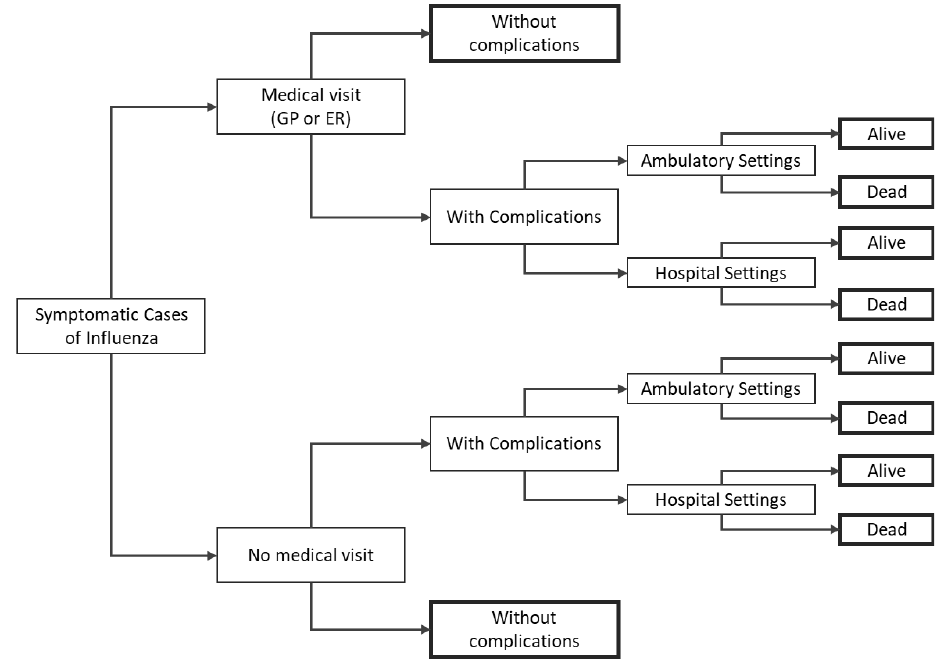
Figure 1. Decision-tree structure for the disease burden module. Note: bold rectangles represent terminal nodes. ER = emergency room; GP = general practitioner